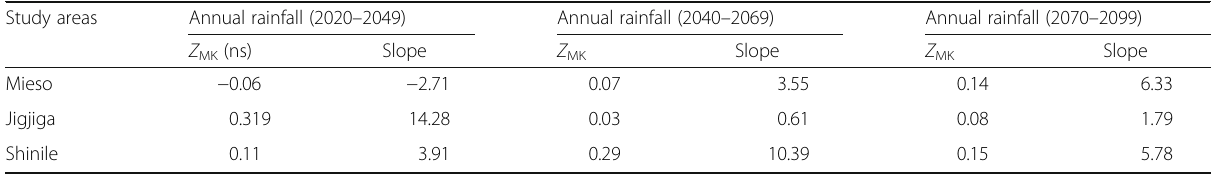
Table 3 Trends of annual rainfall for the period of 2020 – 2049, 2040 – 2069, and 2070 – 2099 in pastoral production systems of Mieso, Jigjiga, and Shinile districts of eastern